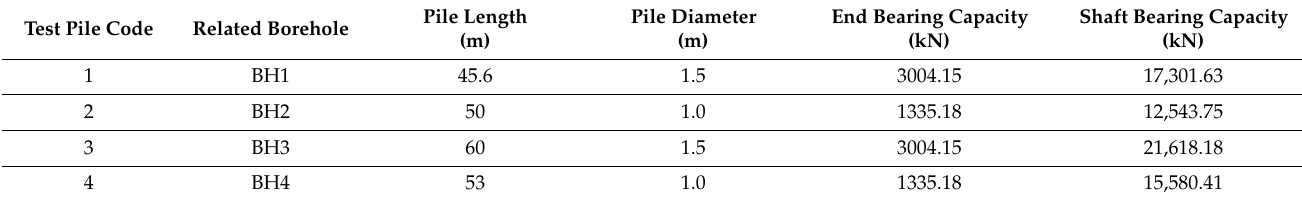
Table 2. Dimensions and estimated bearing capacity of test piles.